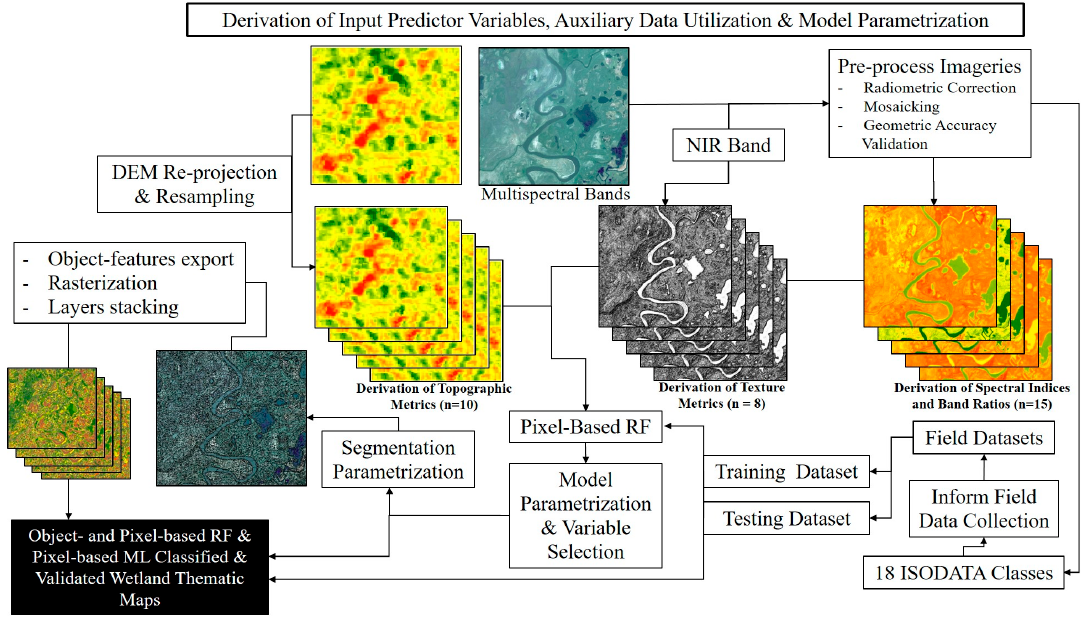
Figure 2. Field and remote sensing data-processing workflow.